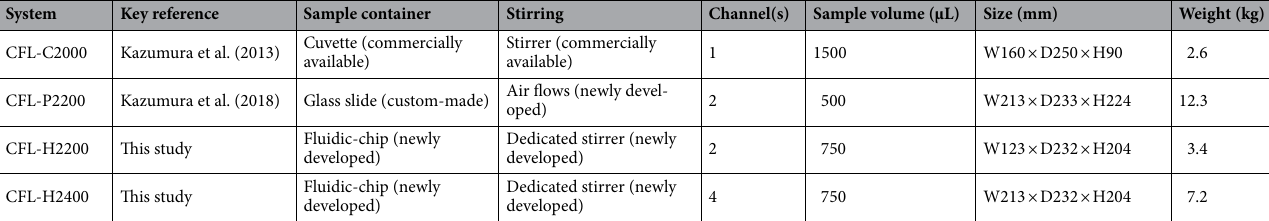
Table 1. A list of simultaneous CL and FL monitoring systems so far developed. CFL-H2200/H2400 achieved the goal which is smaller, lighter, and more energy-efficient than the glass slide-type,